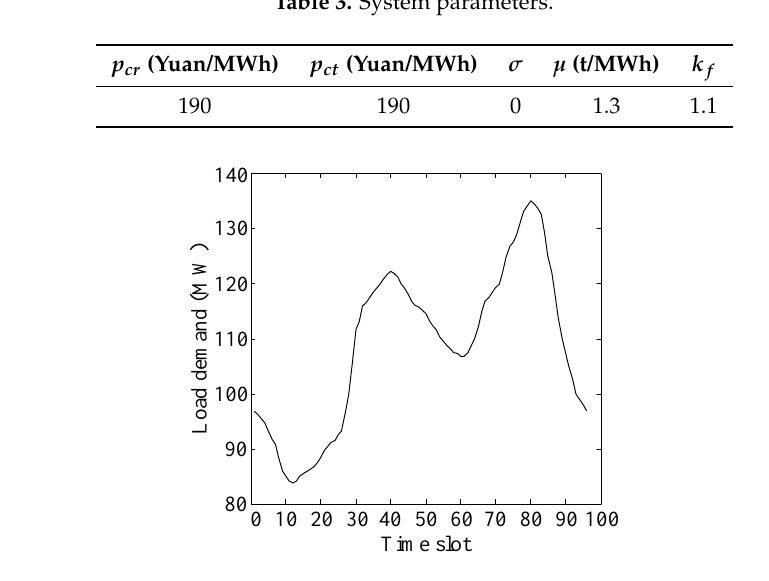
Figure 2. Daily load demand of all utility